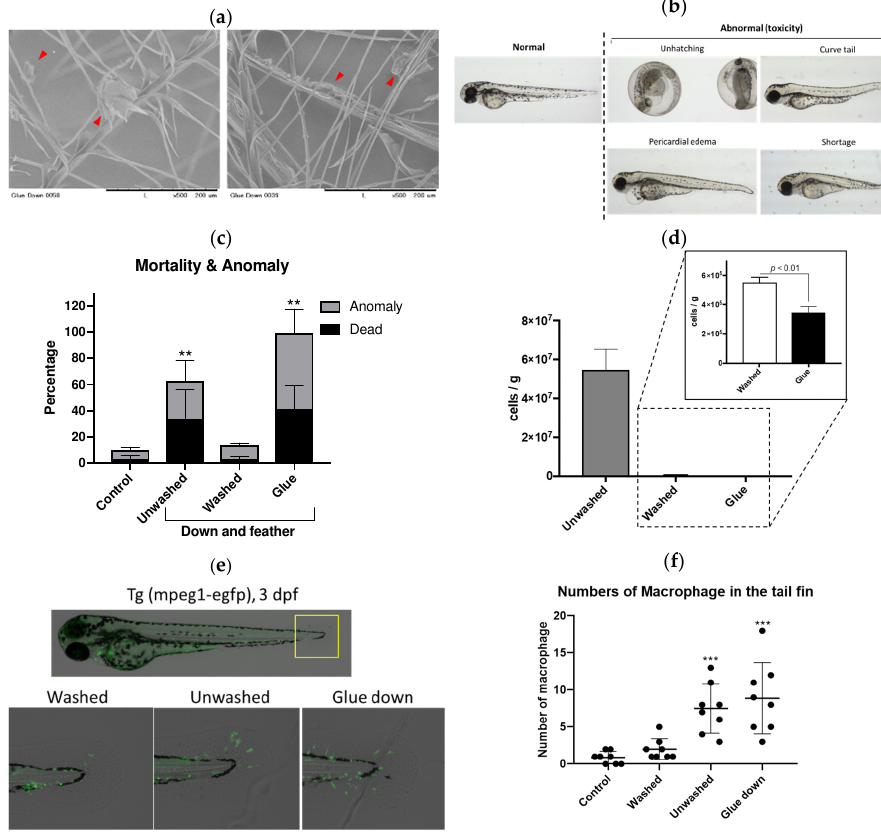
Figure 3. Zebrafish embryo toxicity test (ZFET) of down and feather samples. ( a ) Scanning electron microscopic images of glue down. Red arrowheads indicate glue chemicals. ( b ) Representative images of 72 hours-post-fertilization (hpf) zebrafish in ZFET. ( c ) Survivals and anomalies in ZFET. ** p < 0.01 vs. control. n = 4–6, error bars indicate SD. ( d ) Quantification of contaminated bacterial in down and feather samples used in ZFET. n = 4, error bars indicate SD. ( e ) Representative images of macrophage-EGFP zebrafish used in ZFET. Green indicates EGFP-expressed macrophages. Unwashed and glue down immersion water were diluted 5 times to reduce mortality. ( f ) Quantification of numbers of macrophages in the tail fin. *** p < 0.001 vs. control. n = 8, error bars indicate SD.